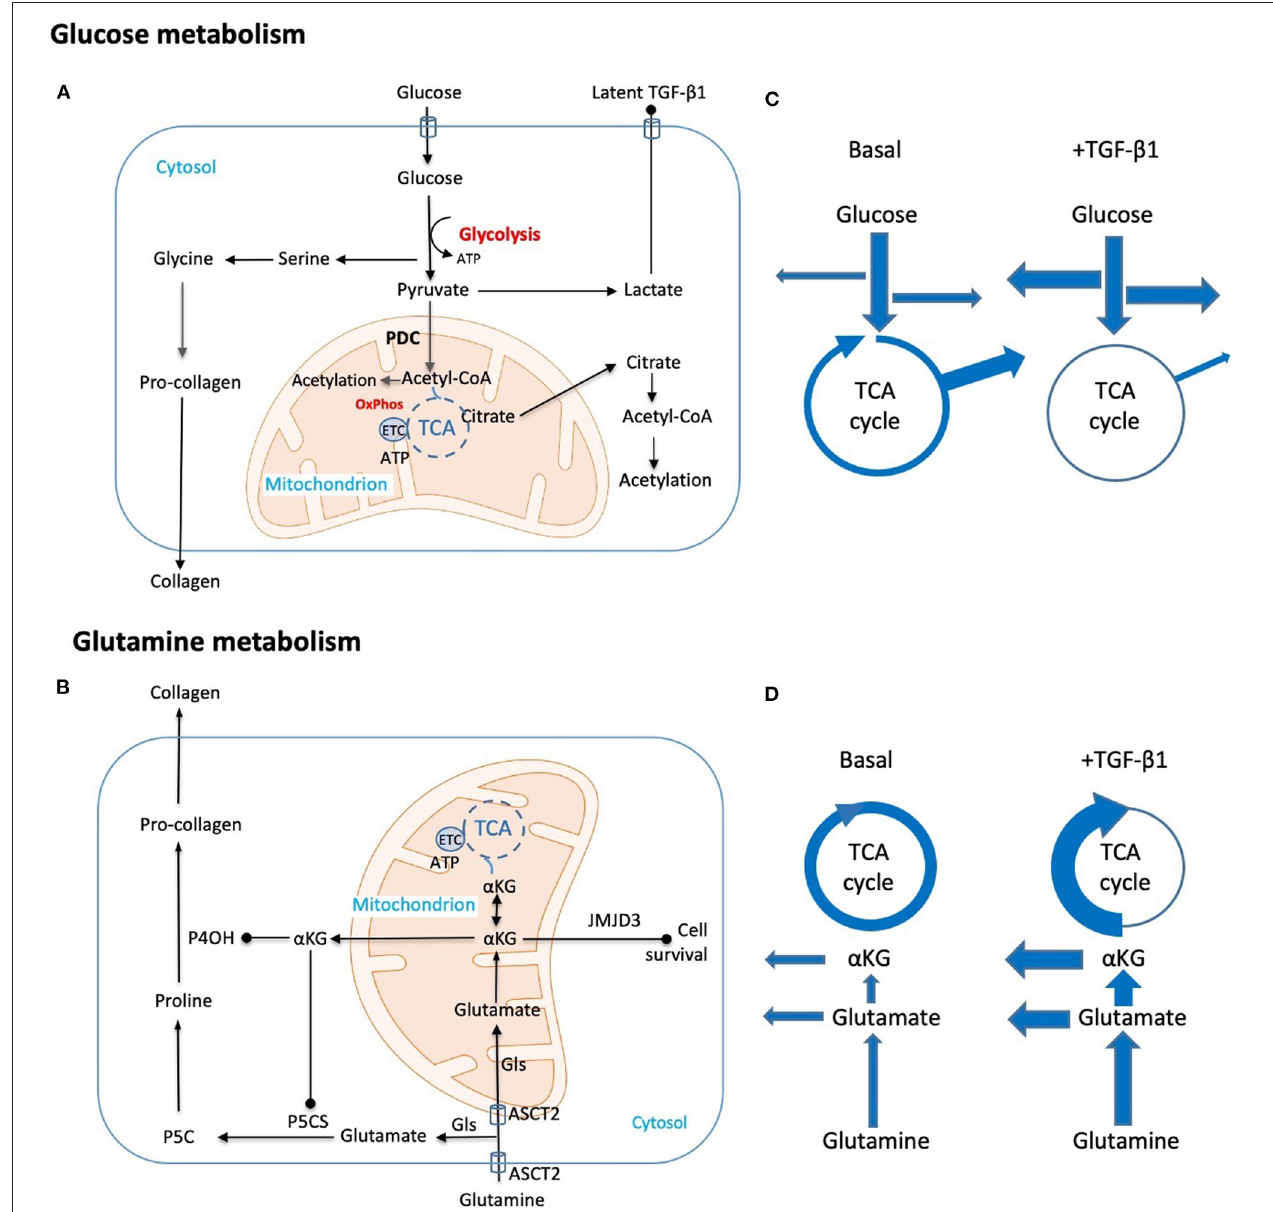
FIGURE 1 | Schematic representation of key metabolic adaptations in fibroblasts to support collagen synthesis. Metabolic and biosynthetic fates of (A) glucose and (B) glutamine highlight potential synthetic (arrow head) and regulatory (solid dot) functions in fibrogenesis. (C,D) Putative changes in metabolic flux caused by TGF- β 1 are diagrammatically indicated by changes in arrow thickness. These include (C) a shift from oxidative phosphorylation to glycolysis with commensurate increases in amino acid and nucleotide synthesis and a reduction in Acetyl-CoA generation. Export of the end product lactate may also be pro-fibrotic as local changes to pH contribute to activation of latent TGF- β . (D) Parallel hypothesized TGF- β 1 induced changes in glutamine metabolism both supplement amino acid synthesis and TCA intermediates lost through metabolic shifts in glucose metabolism. Key: Acetyl-CoA, Acetyl coenzyme-A; ASCT2, alanine-serine-cysteine transporter 2; α KG, α -ketoglutarate; ATP, adenosine triphosphate; ETC, electron transport chain; Gls, glutaminase; JMJD3, Jumonji domain-containing protein D3; OxPhos, oxidative phosphorylation; P4OH, prolyl-4-hydroxylase; P5CS, pyrroline-5-carboxylate synthase; P5C, pyrroline-5-carboxylate; PDC, pyruvate dehydrogenase complex; TCA, tricarboxylic acid cycle; TGF- β 1, transforming growth factor- β